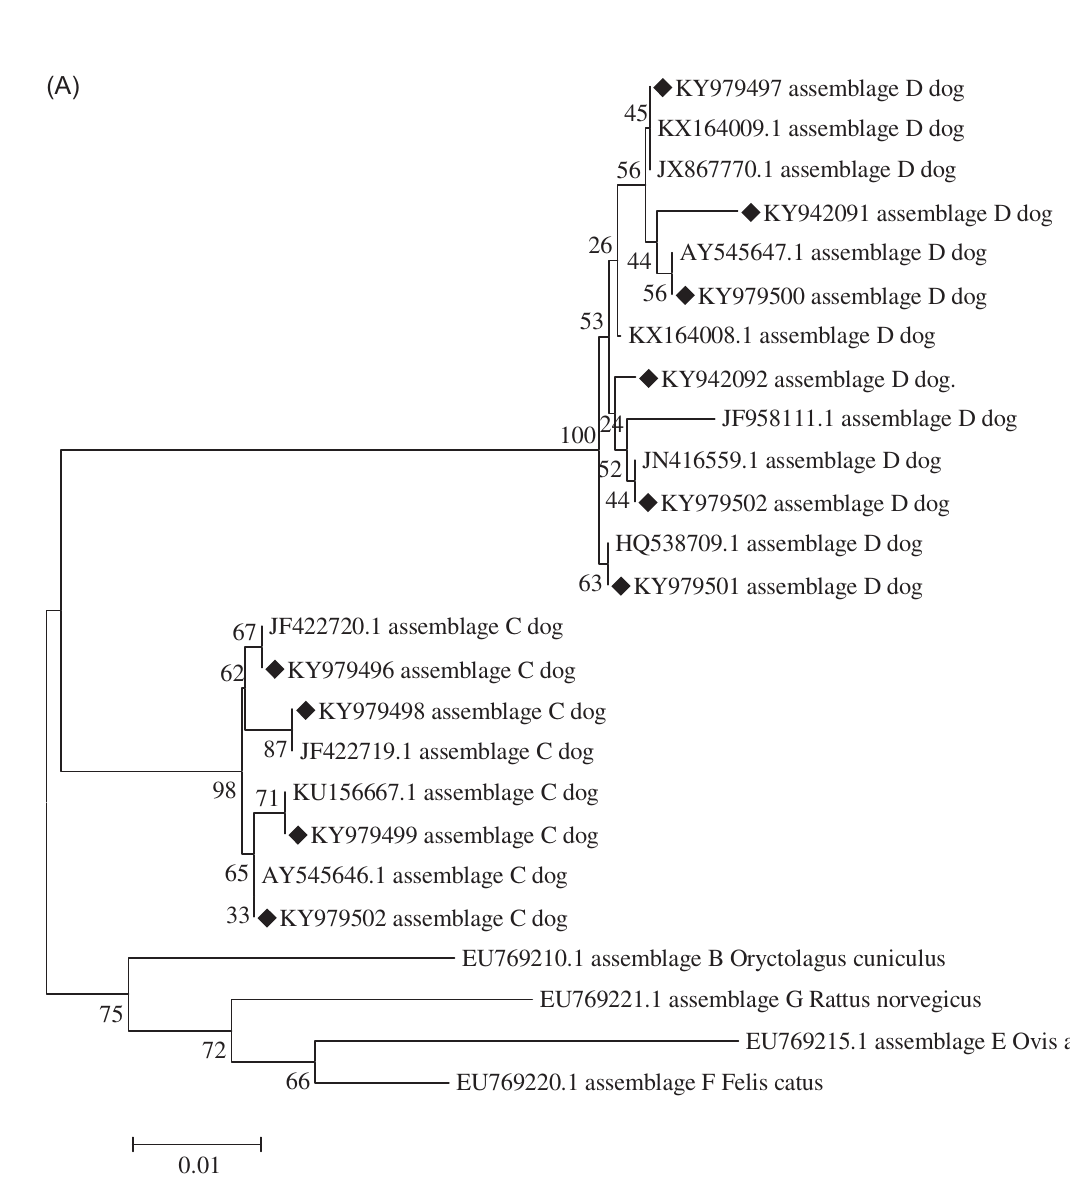
Figure 1. Phylogenetic relationships of Giardia duodenalis at the bg , gdh, and tpi loci. The relationships between G. duodenalis genotypes identified in this study and other known genotypes deposited in GenBank were inferred by a neighbor-joining analysis of three genetic loci using the Kimura 2-parameter model. Bootstrap values greater than 50% from 1,000 replicates are shown. (A) Tree based on the beta giardin ( bg ) gene. (B) Tree based on the glutamate dehydrogenase ( gdh ) gene. (C) Tree based on the triosephosphate isomerase ( tpi ) gene. Sequences obtained in this study are marked with ‘‘ (cid:2)